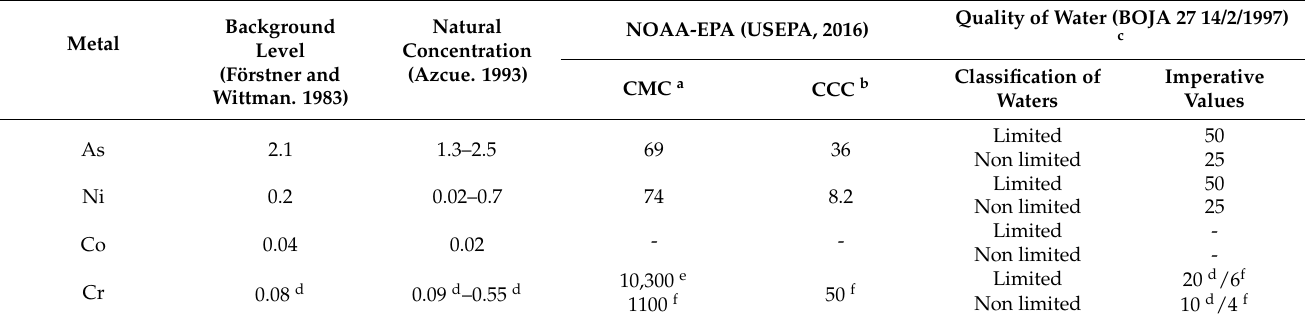
NOAA-EPA (USEPA, 2016) CMC a CCC b